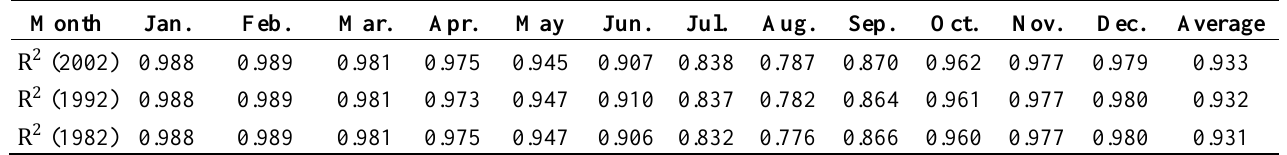
Table 5. R 2 in the OLS regression models calibrated for validating the monthly sea ice concentration in 2002, 1992, and